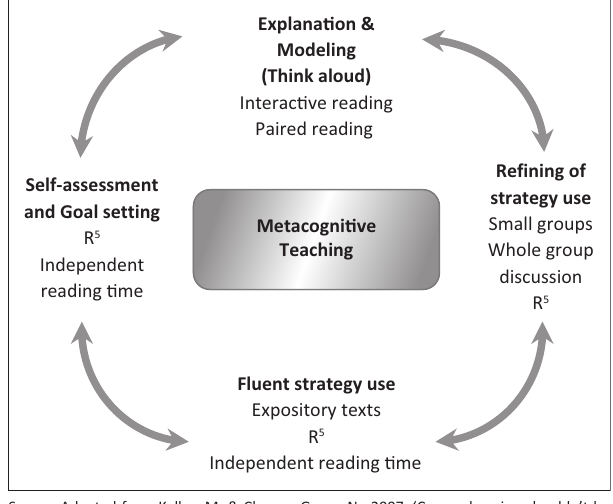
FIGURE 1: The Metacognitive Teaching Framework